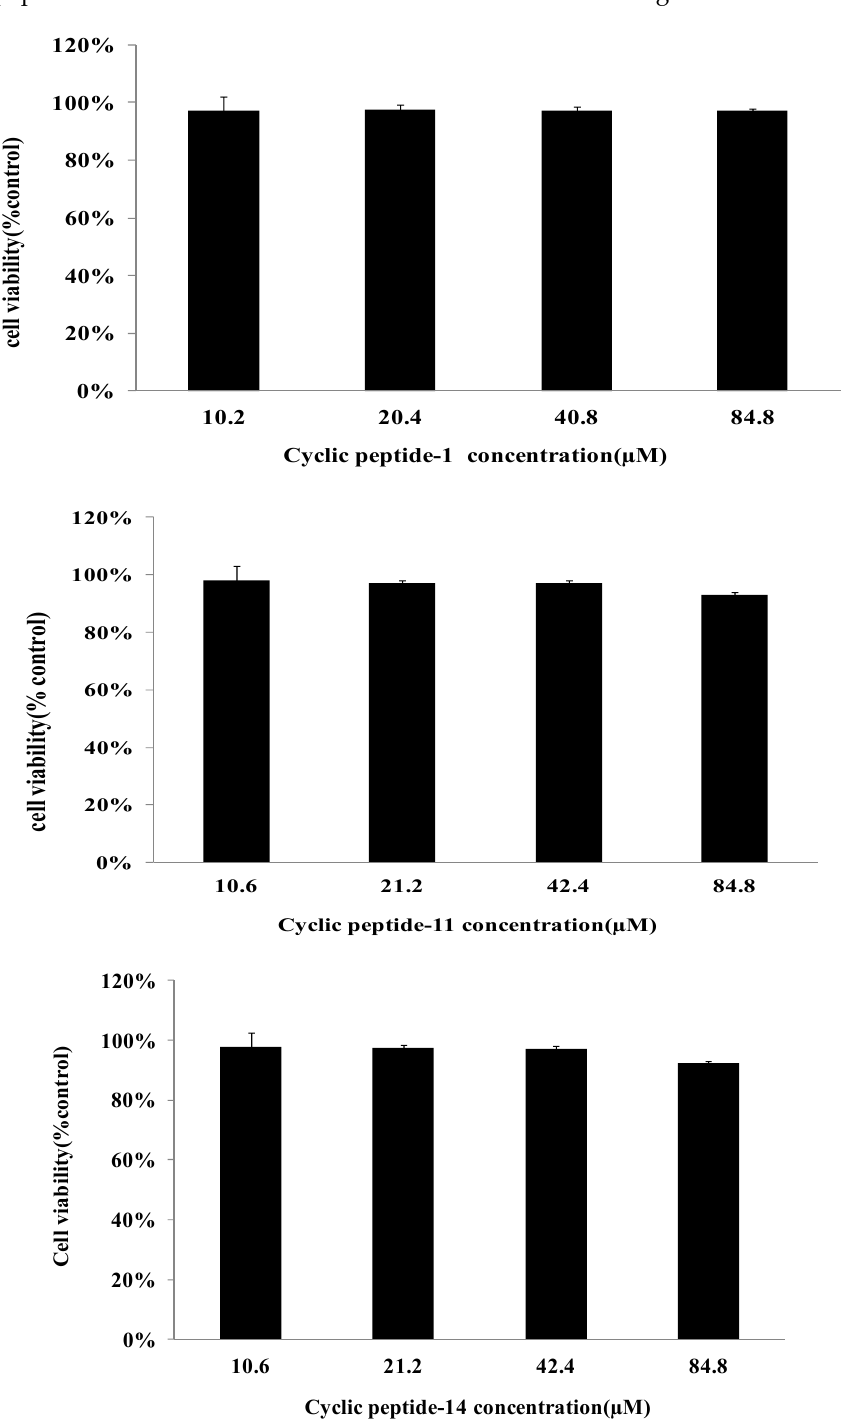
Figure 7. Cytotoxicity assay of cyclic peptide-1, -11, and -14 against human liver L02.